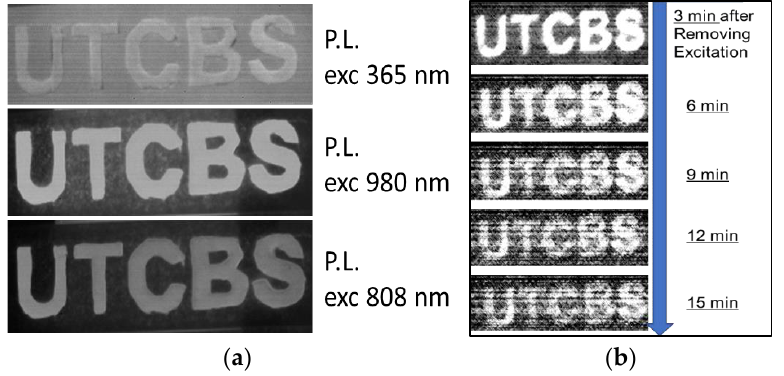
Figure 7. ( a ) PL of the “UTCBS” pattern noted by ZGSO -3:Ni 2+ , Er 3+ NPs under excitation at 365 nm, 980 nm, and 808 nm, respectively. ( b ) Persistent luminescence images of the “UTCBS” pattern noted by ZGSO-3:Ni 2+ , Er 3+ NPs after removal of 365 nm excitation for 5 min. All images were collected with an InGaAs camera.